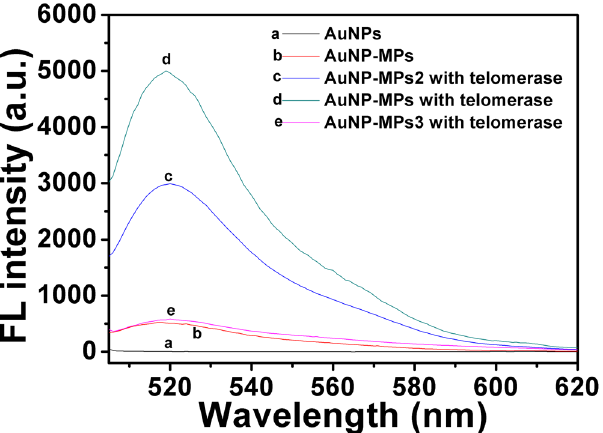
Figure 2. Fluorescence response of bare AuNPs ( a ), HP-1 (with toehold)-modified AuNPs (AuNP-MPs) in the absence of telomerase ( b ), HP-2 (without toehold)-modified AuNPs (AuNP-MPs2) after incubation with telomerase for 2 h ( c ), HP-1 (with toehold)-modified AuNPs (AuNP-MPs) after incubation with telomerase for 2 h ( d ) and HP-3-modified AuNPs (AuNP-MPs3) after incubation with telomerase for 2 h ( e